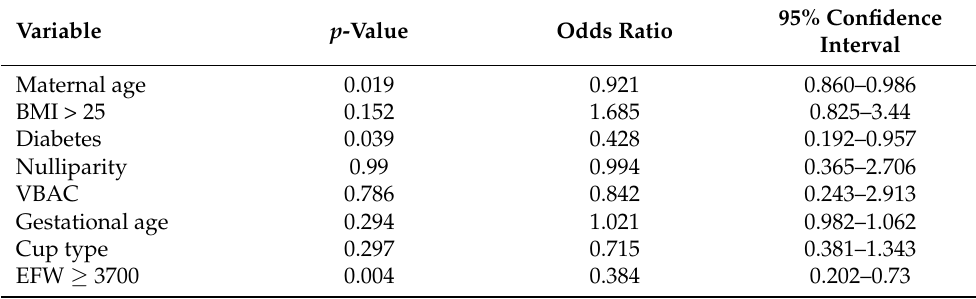
Table 4. Multivariate logistic regression analysis for adverse outcome (defined if shoulder dysto- cia/clavicular fracture/third- or fourth-degree perineal tear